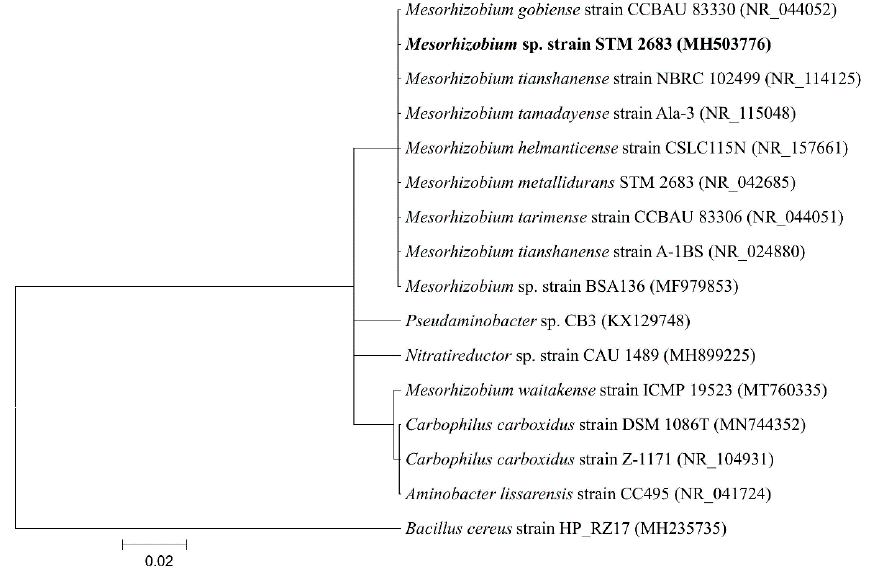
Figure 2. Phylogenetic tree of K-solubilizing KSB (Grz) strain based on 16S rDNA sequences.